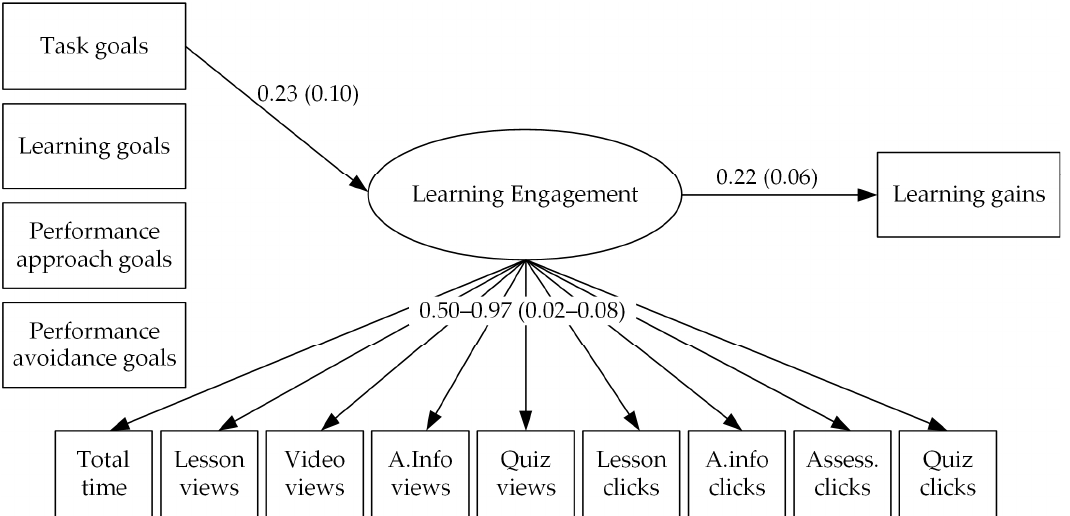
Figure 1. Results of analyzing the associations between achievement goals, learning engagement, and learning gains (only statistically significant effects are visualized, residuals and their correlations are not presented). We present standardized regression weights/factor loadings with their standard errors in brackets.